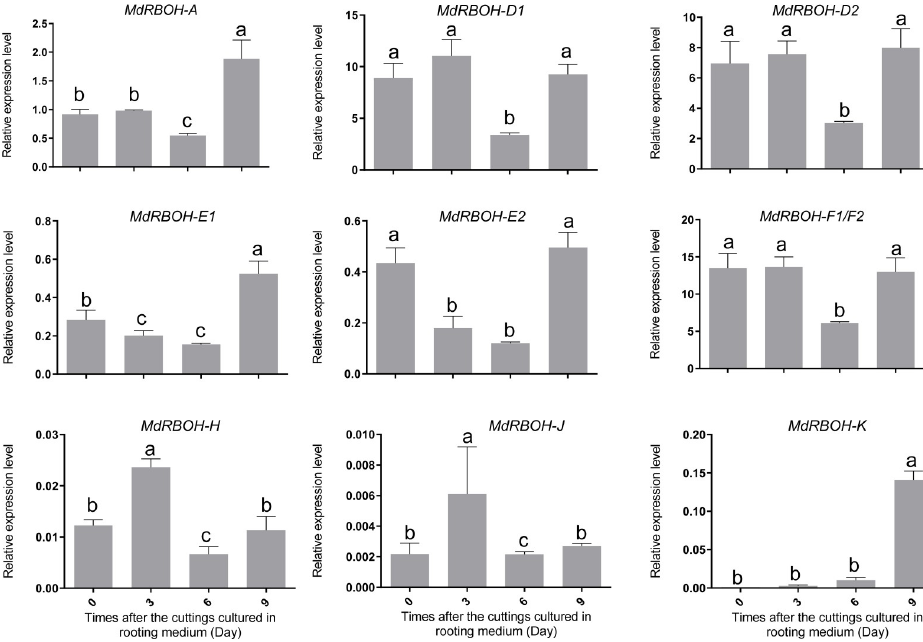
Fig 7. Relative expression levels of MdRBOH genes during the adventitious rooting process. Relative transcript levels of 10 MdRBOH genes were measured in stem tissue after the cuttings had been transferred to rooting medium for 0, 3, 6, or 9 days. Transcript levels were measured by qRT-PCR using apple EF1 α as the reference gene. Data are means ± SD of three biological replicates. Refer to S1 Table for primers. The statistical analysis was conducted using Duncan’s multiple range test ( P < 0.05). The different lowercase letters indicate significant